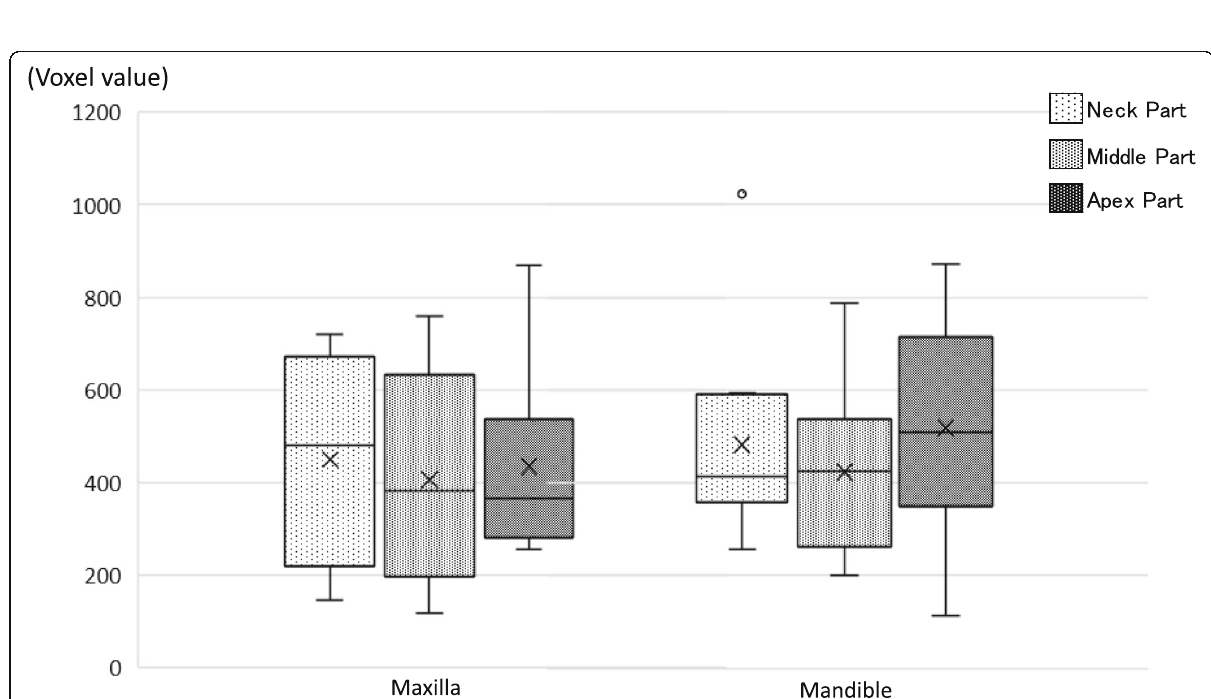
Fig. 6 The relationship between ISQ and insertion torque. Percentage of specimens showing ISQ ≥ 73 compared with groups by week. In all groups, a period of rapidly increasing percentages was observed (8 – 12 weeks in the low IT group, 4 – 6 weeks in the medium and high IT groups). In the medium and high IT Group, a statistically significant difference was observed between ISQ ≥ 73 and ISQ < 72 ( P < 0.05)